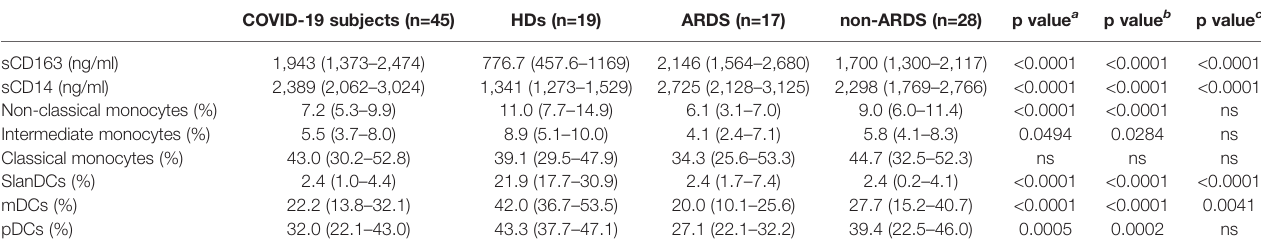
TABLE 2 | sCD163 and sCD14 plasmatic levels and immunophenotyping